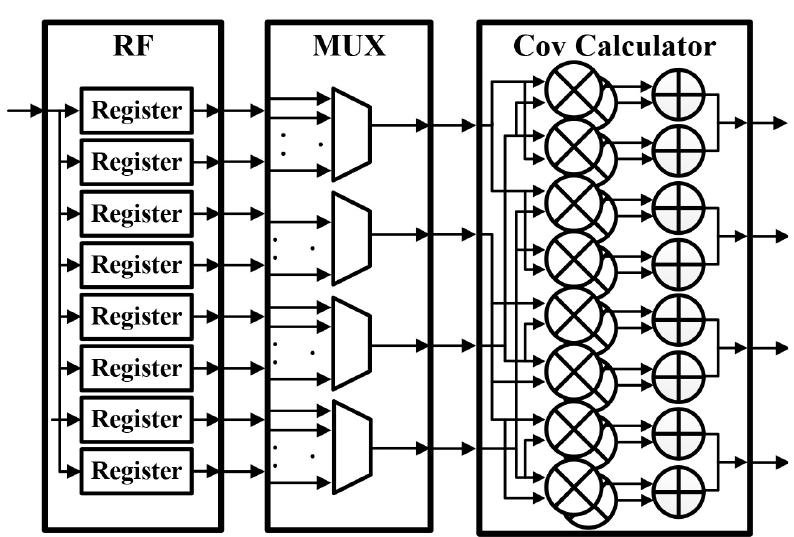
Figure 7. Hardware architecture of covariance matrix module